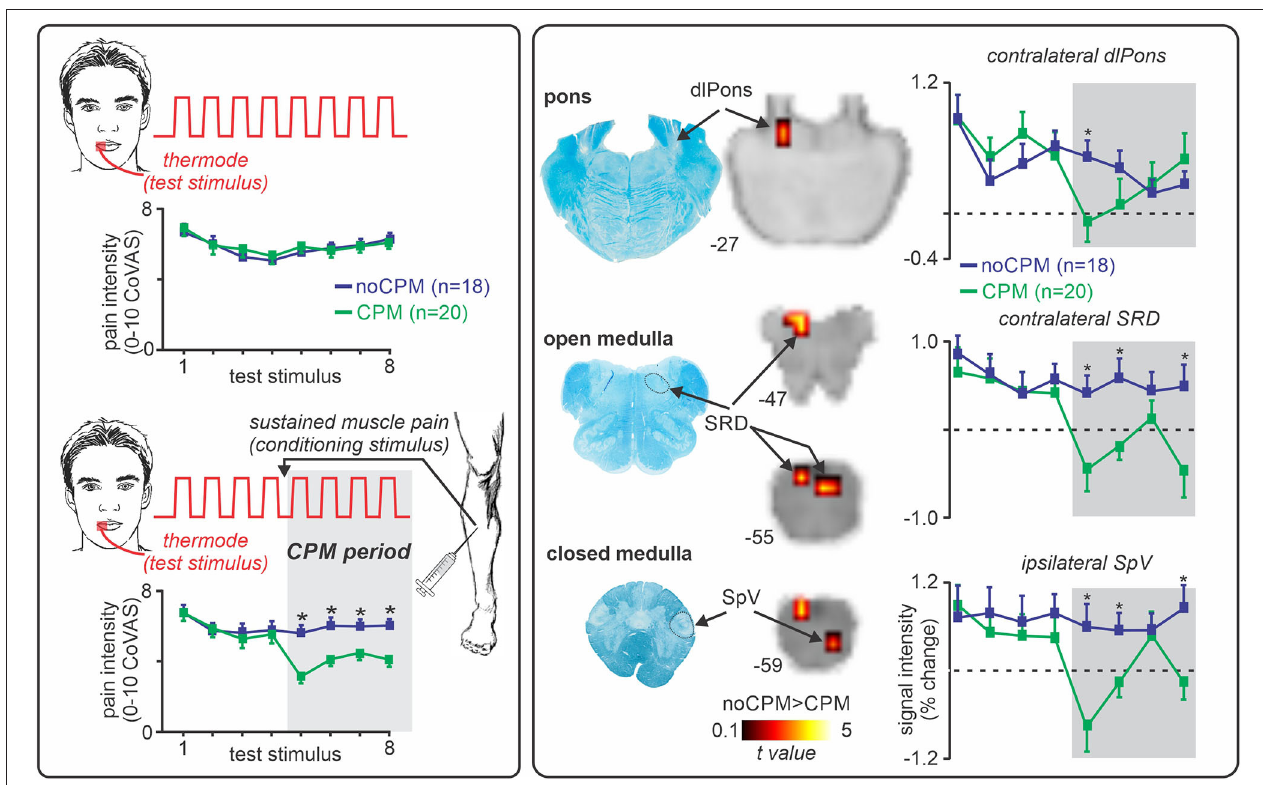
FIGURE 3 | Role of the subnucleus reticularis dorsalis (SRD) in conditioned pain modulation (CPM). Left panel: CPM is assessed by measuring the change in pain intensity to a single noxious stimulus (“test stimulus,” noxious thermal stimulus), by the application of a second noxious stimulus (“conditioning stimulus,” sustained muscle pain). Approximately 50% of individuals experience a reduction in pain intensity during the conditioning stimulus (CPM responders, green), where the remainder do not (CPM non-responders, blue). *significant between-groups difference, two-sample t -test, p < 0.05. Right panel: During a CPM paradigm, CPM responders show a decrease in signal intensity changes in the dorsolateral (dl) pons, the SRD, and spinal trigeminal nucleus (SpV) compared to non-responders. *significant between-groups difference, two-sample t -test, p < 0.05. Figure modified with permission from Youssef et al. (